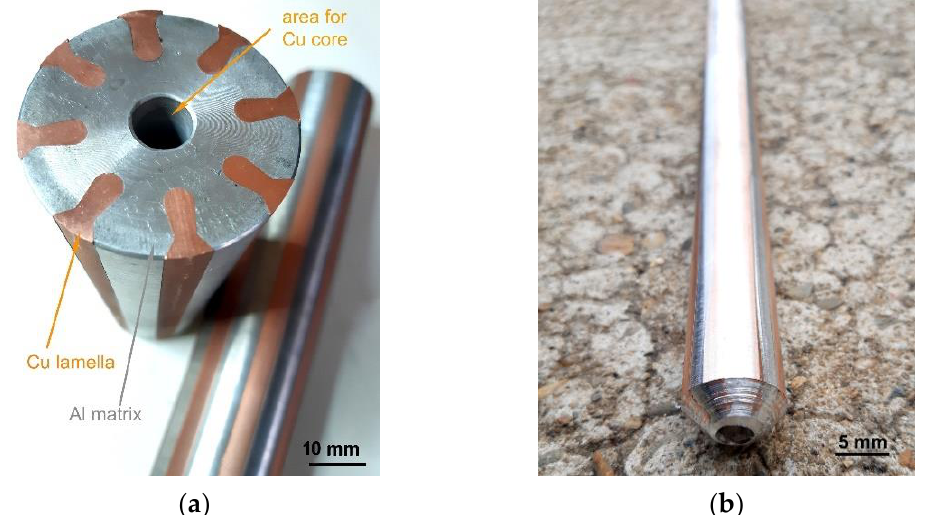
Figure 1. Assembled Al–Cu semi-product before inserting Cu core ( a ); swaged composite rod 10 mm in diameter ( b ).